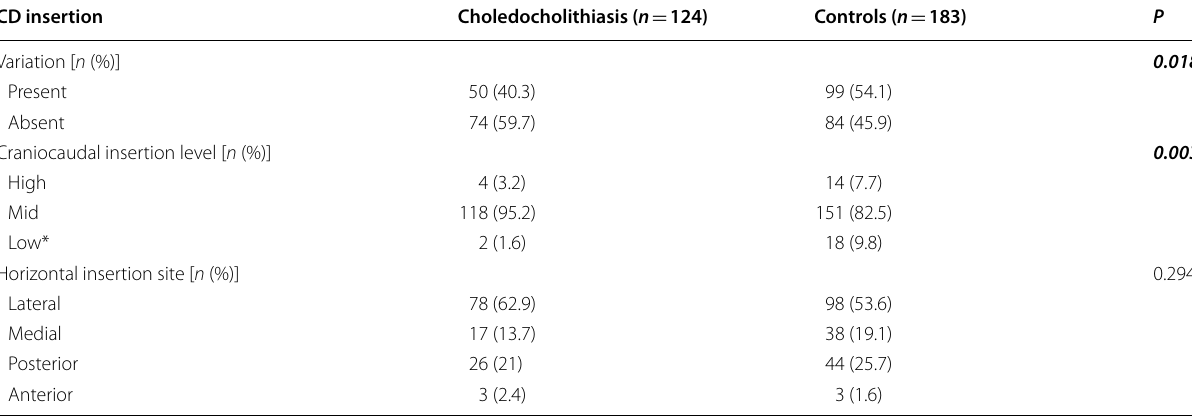
Table 3 Intergroup differences of CD insertion